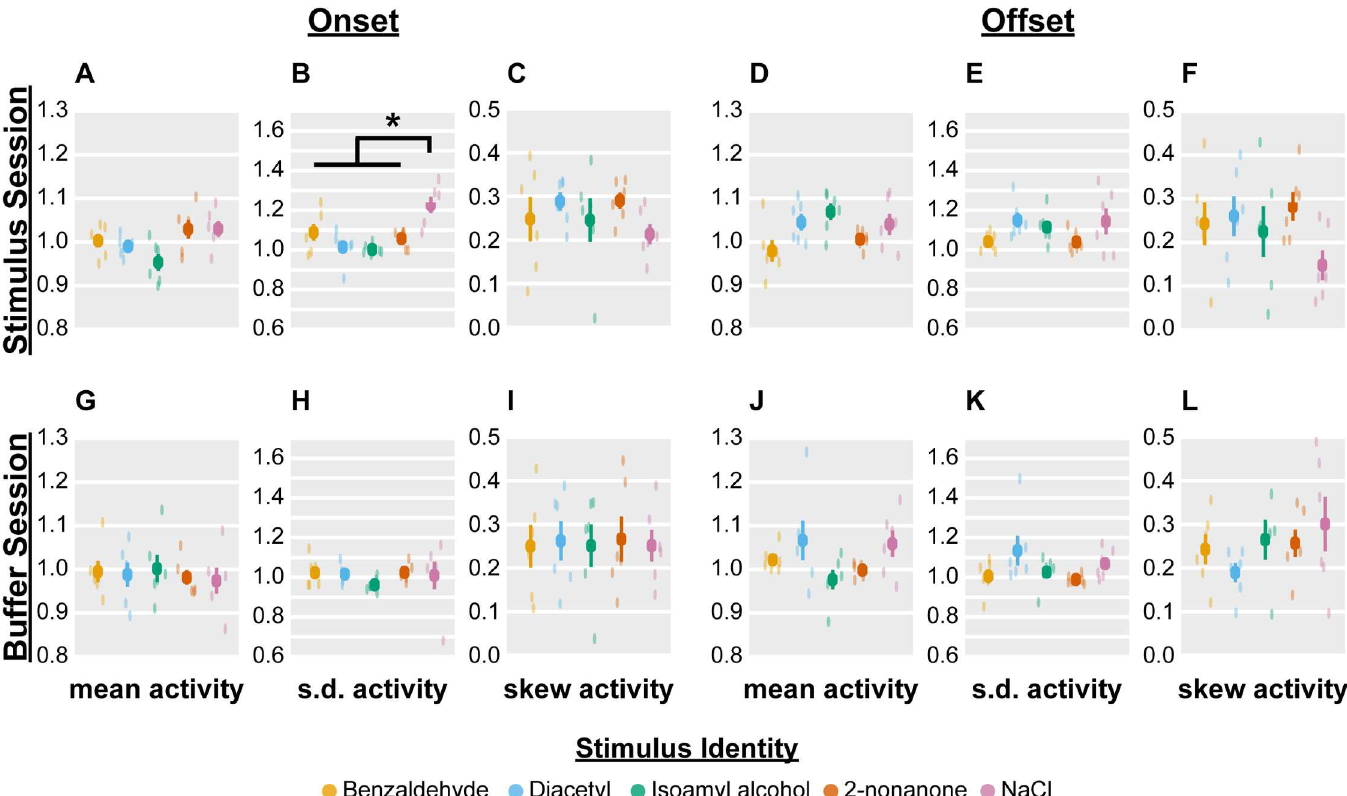
Fig 2. Neural network activity features are not modulated by stimulus identity. Activity features were computed upon stimulus onset (A, B, C, G, H, I) or offset (D, E, F, J, K, L) of an odorant/tastant (A, B, C, D, E, F) or M9 buffer stimulus (G, H, I, J, K, L). “Mean activity” refers to the mean change of mean population activity relative to baseline, “s.d. activity” refers to the mean change of the standard deviation of population activity relative to baseline, and “skew activity” refers to the mean change of the skewness of population activity relative to baseline, where baseline is the 30-second period preceding chemical onset or offset. Each color dot is the mean value across all seven pulses for a single worm, and the dark squares and lines indicate the mean and standard error of the mean across all worms (n = 6 worms per stimulus). p > 0.05 for all comparisons after Bonferroni correction with effective number of variables meff = 27.1, except panel B (p = 1.1e-4). However, note that p = 0.02 for panel B in Data Set 2, which does not survive Bonferroni correction with meff = 6.2 (hence, no red star). We used the likelihood ratio test on full and null generalized linear-mixed effects models (GLMEs), where the former included stimulus identity as a fixed effect, to compute the aforementioned p-values. We then used pairwise F-tests for Data Set 1 on the stimulus coefficients of the full GLME to compute pairwise significance, which is indicated by � and the bar connecting NaCl and the rest of chemicals in panel B. The F-tests used Bonferonni correction based on the total number of distinct pairwise comparisons (i.e., alpha = 0.05/10).